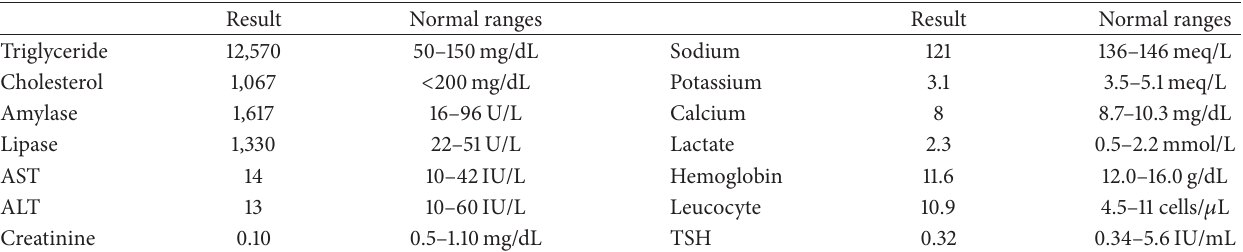
Table 1: Patient’s laboratory data on admission.